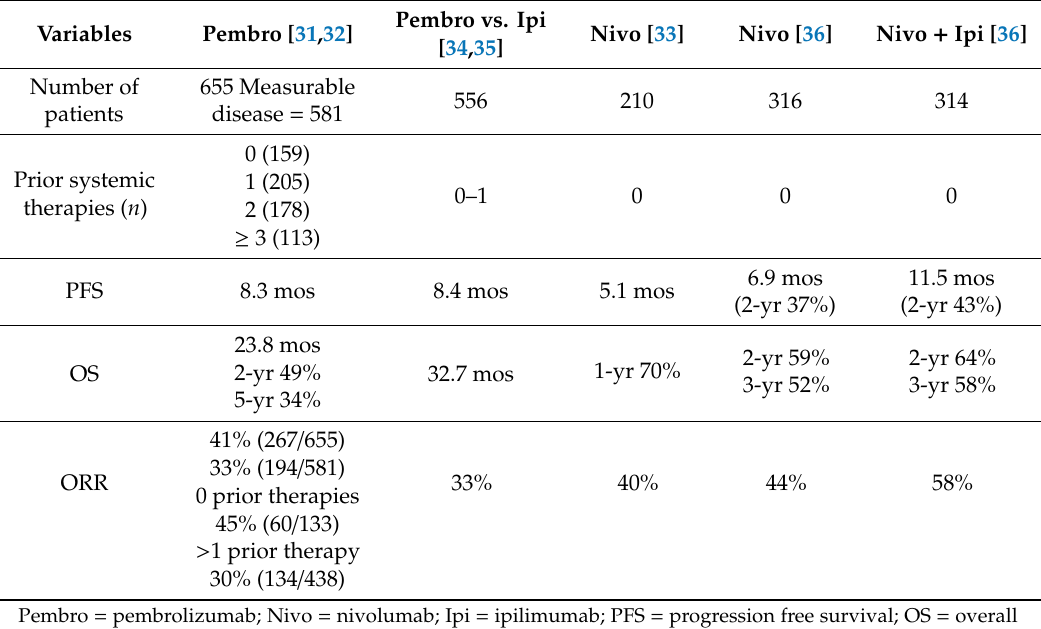
Table 5. Trials of anti-PD-1 with or without anti-CTLA-4 in patients with metastatic melanoma who previously had or had not received systemic